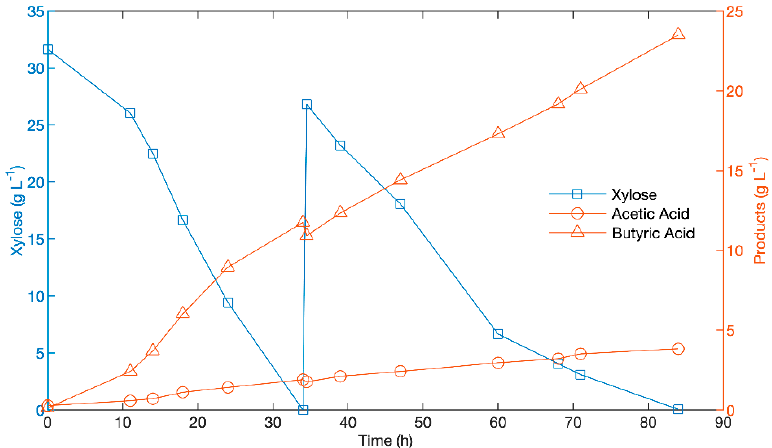
Figure 1. Xylose consumption and product formation in a fed-batch fermentation strategy of Clostridium tyrobutyricum to produce butyric acid rich supernatant. Culture was grown in a 7 L reactor with a 5 L initial filling volume, and maintained at a pH of 6.3 to select for butyric acid production. Final values for detectable products were (in g/L): butyric acid = 23.5; acetic acid = 3.8.